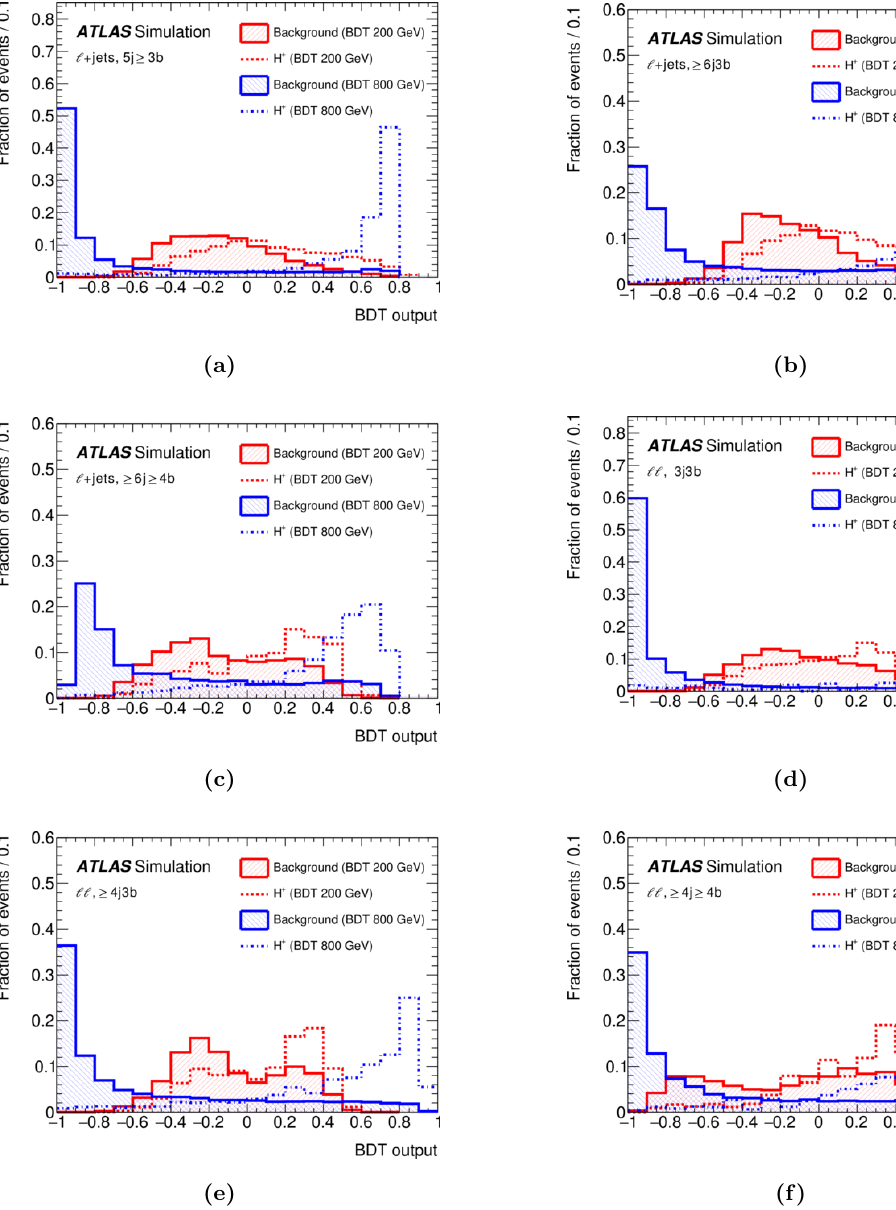
Figure 5. The expected output distributions of the BDTs employed for H + masses of 200 GeV and 800 GeV for SM backgrounds and H + signal in the three ‘ +jets and the three ‘‘ SRs used in the BDT training: (a) ‘ +jets (cid:12)nal state, 5j (cid:21) 3b, (b) ‘ +jets (cid:12)nal state, (cid:21) 6j3b, (c) ‘ +jets (cid:12)nal state, (cid:21) 6j (cid:21) 4b, (d) ‘‘ (cid:12)nal state, 3j3b, (e) ‘‘ (cid:12)nal state, (cid:21) 4j3b and (f) ‘‘ (cid:12)nal state, (cid:21) 4j (cid:21) 4b. All distributions are normalised to unity.